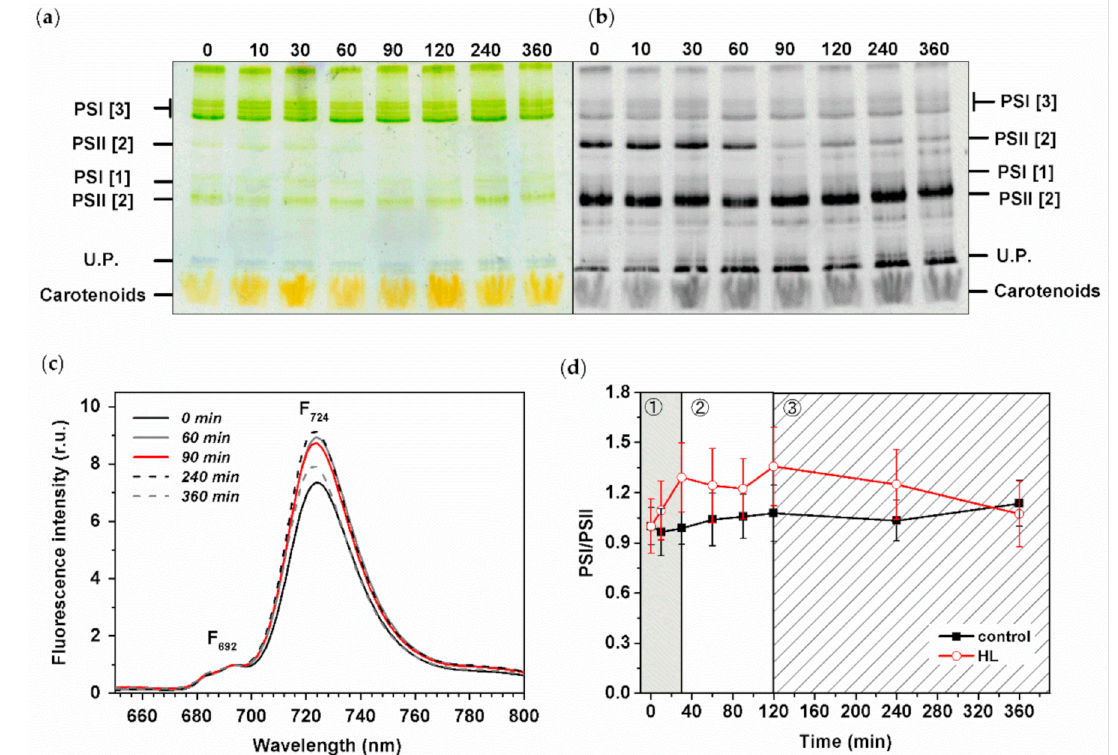
Figure 5. Biochemical and spectroscopic analysis of pigment–protein complexes of HL treated Synechocystis PSI - YFP cells . Thylakoid membranes were isolated from the cells and analyzed by CN-PAGE. Gels were imaged as a color-scanned picture ( a ) or as chlorophyll autofluorescence pictures ( b ). Numbers represent time points (in minutes) of HL treatment. Designation of complexes: PSI [3], PSI [1] trimeric and monomeric PSI complexes; PSII [2] and PSII [1] dimeric and monomeric PSII core complex; U.P. = unbound proteins. Each loaded sample contained 5 µ g of Chl. ( c ) Normalized 77K fluorescence emission spectra at 692 nm (450 nm excitation) at different times of HL treatment. Straight black line = time 0 min; straight grey line = time 60 min; red line = time 90 min; dashed black line = time 240 min; dashed grey line = time 360 min. Positions of F 692 and F 724 representing PSII and PSI maximal emission, respectively, are marked. ( d ) Spectroscopic analyses of PSI/PSII ratio based on 77K fluorescence (excitation at 450 nm) for HL and control cells. PSI/PSII ratio deduced from the intensity of fluorescence of F 692 (PSII maxim) and F 724 (PSI maxim). Data represent averages and SD of four biological replicates and normalized to values at 0 min. The three phases of cyanobacterial cell response to HL (see Konert et al. (2019) [5]) are marked by different background colors and numbers (grey—fast response; white—intermediate phase; striped—acclimation